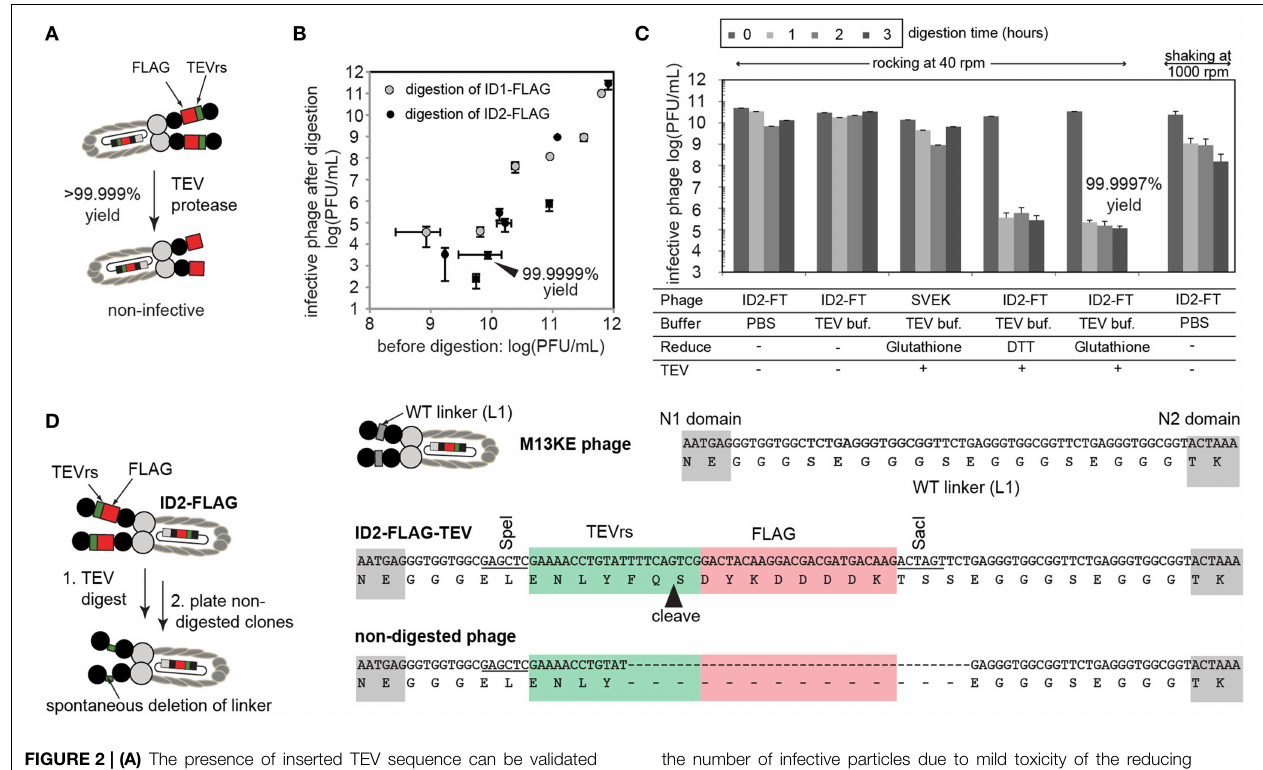
FIGURE 2 | (A) The presence of inserted TEV sequence can be validated by enzymatic digestion of the phage and by measuring the number of infective particles before and after digestion by TEV-protease. (B) Under optimized conditions (dilute concentration of phage), digestion efficiency can reach an apparent 99.9999%, indicating that the majority of phage display the insert. Each point describes a separate digestion experiment. Error bars describe standard deviation of titering. (C) Optimization of buffer, reducing agents, and mixing conditions used for digestion. Interestingly, simple vigorous shaking at 1000rpm leads to drastic loss of infective particles. With gentle rocking, we observed a minor decrease in